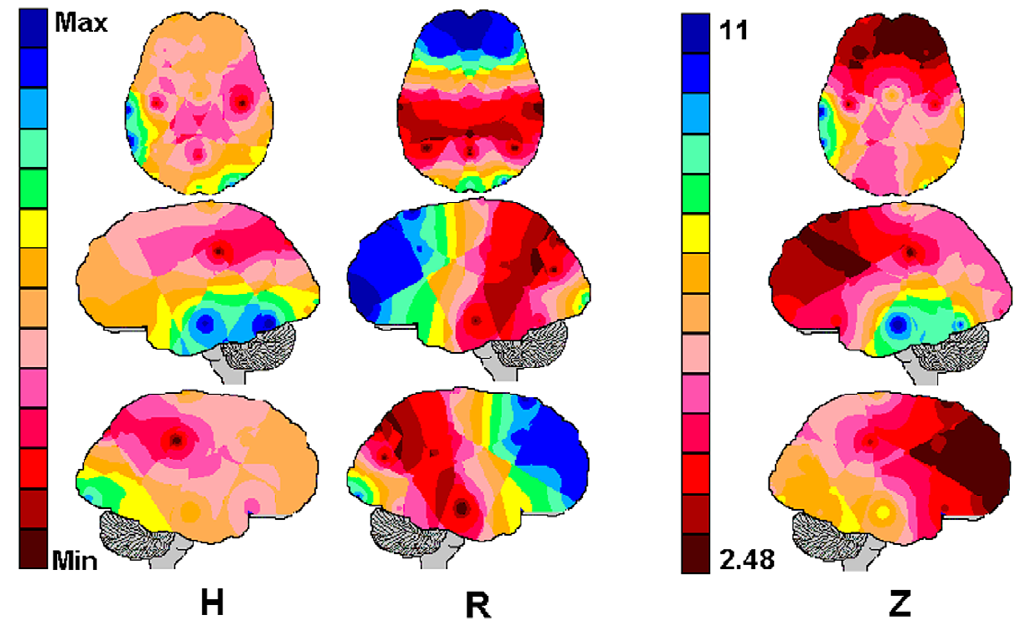
Figure 1. Comparison between a ‘‘Hypothetical’’ (H) and the Real (R) Brains. The Hypothetical brain was obtained by randomizing the calculated entropies (see text for further details. The actual calculated entropies were used to obtain the Real brain. The mappings H and R depict the averaging of these entropies. The comparison between averaging mappings H and R was quantified by the Z-scores shown by the mapping Z. Noted that the minimum Z-score was 2.48 and the maximum was 11. brain mappings shown in figure 2. The Pearson’s correlation coefficient for these two mappings was 2 0.27. In women, high IQ is mostly associated with high h ( e i ) for the left brain and with low h ( e i ) for the right hemisphere electrodes. In men, an opposite pattern was observed, with high IQ mostly associated with high h ( e i ) for the right brain and low h ( e i ) for the left hemisphere electrodes. The multiple regression IQ ~ a z b 1 h ( e 1 ) z ::: z b 20 h ( e 20 ) , cal- culated separately for adults and children, was used to obtain the brain mappings shown in figure 3. The Pearson’s correlation coefficient for these two mappings was 2 0.16. The inverse correlation between IQ and h e i ð Þ calculated for the right anterior frontal and right posterior electrodes, was similar in both groups. The main difference between the two mappings was the opposite relationship between IQ and h e i ð Þ calculated for the left anterior electrodes. For these electrodes IQ was inversely correlated with h e i ð Þ in adults and directly correlated with h e i ð Þ in children. Finally, a positive correlation between IQ and h e i ð Þ generally dominated in children compared with adults.